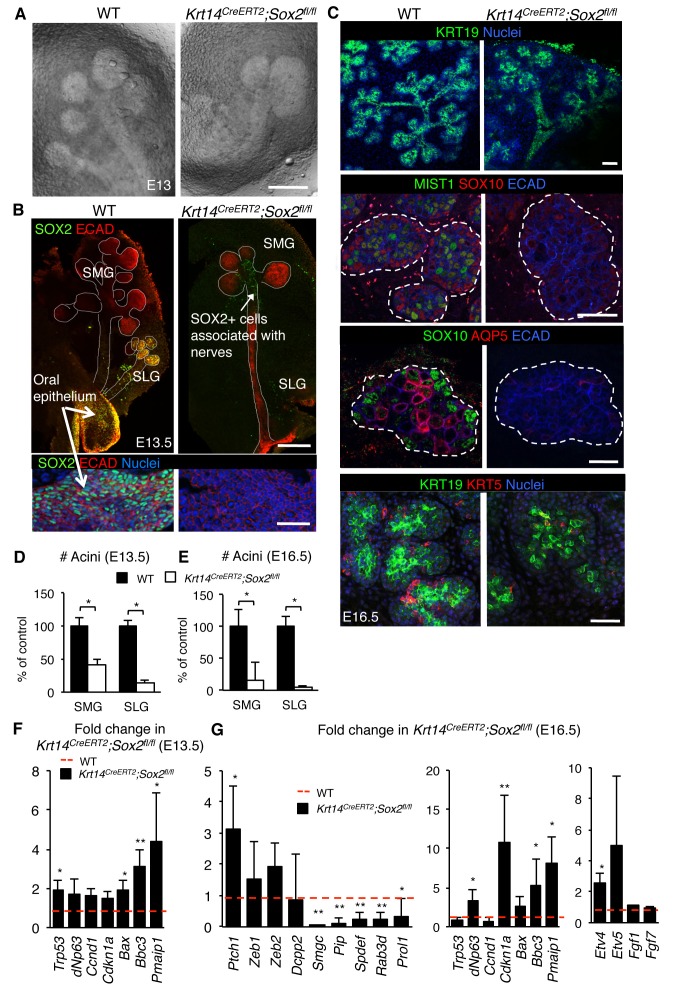
Acini are depleted in the absence of Sox2.Representative images of Krt14CreERT2; Sox2fl/fl and wild-type (WT) SMG+SLG at E13 (A; scale bar is 100 μm), E13.5 (B; top and bottom panels; scale bars are 100 and 50 μm, respectively) and E16.5 (C; scale bar is 200 µm (top panels), 50 µm (second and fourth panels) and 10 µm (third panels)). SMG = submandibular gland, SLG = sublingual gland. E13.5 SGs (B) were immunostained for SOX2 and E-cadherin (ECAD) and E16.5 SMG+SLG (C) for KRT19, MIST1, SOX10, AQP5, KRT5, Ecadherin (ECAD) and nuclei. Dashed white lines outline acini. Lower panel in B highlights the oral epithelium of the E13.5 SG. (D–E) Quantification of acini at E13.5 and E16.5 is shown in D (n = 3–7) and E (n = 3), with WT set to 100%. Data in D and E were analyzed using a Student’s t-test, *p<0.05, **p<0.01. (F and G) qPCR analysis of gene expression of SG from Krt14CreERT2; Sox2fl/fl versus wild-type littermate (WT) at E13.5 (F) and E16.5 (G). Red dashed line = WT. Data are means+s.d. of 3–4 SMG+SLG per genotype. Data in F and G were analyzed using a one-way analysis of variance with a post-hoc Dunnett’s test. *p<0.05, **p<0.01.DOI:
http://dx.doi.org/10.7554/eLife.26620.00910.7554/eLife.26620.010Figure 2—figure supplement 1—source data 1.Source data relating to Figure 2—figure supplement 1D.Quantification of acini in Krt14CreERT2; Sox2fl/fl and wild-type (WT) glands at E13.5, with WT set to 100%. n = 3–7. s.d. = standard deviation.DOI:
http://dx.doi.org/10.7554/eLife.26620.01010.7554/eLife.26620.011Figure 2—figure supplement 1—source data 2.Source data relating to Figure 2—figure supplement 1E.Quantification of acini in Krt14CreERT2; Sox2fl/fl and wild-type (WT) glands at E16.5, with WT set to 100%. n = 3–7. s.d. = standard deviation.DOI:
http://dx.doi.org/10.7554/eLife.26620.01110.7554/eLife.26620.012Figure 2—figure supplement 1—source data 3.Source data relating to Figure 2—figure supplement 1F.qPCR analysis of gene expression in Krt14CreERT2; Sox2fl/fl and wild-type (WT) glands at E13.5. Data were normalized to Rsp29 and WT. n = 3–4 SMG+SLG per genotype. s.d. = standard deviation.DOI:
http://dx.doi.org/10.7554/eLife.26620.01210.7554/eLife.26620.013Figure 2—figure supplement 1—source data 4.Source data relating to Figure 2—figure supplement 1G.qPCR analysis of gene expression in Krt14CreERT2; Sox2fl/fl and wild-type (WT) glands at E16.5. Data were normalized to Rsp29 and WT. n = 3–4 SMG+SLG per genotype. s.d. = standard deviation.